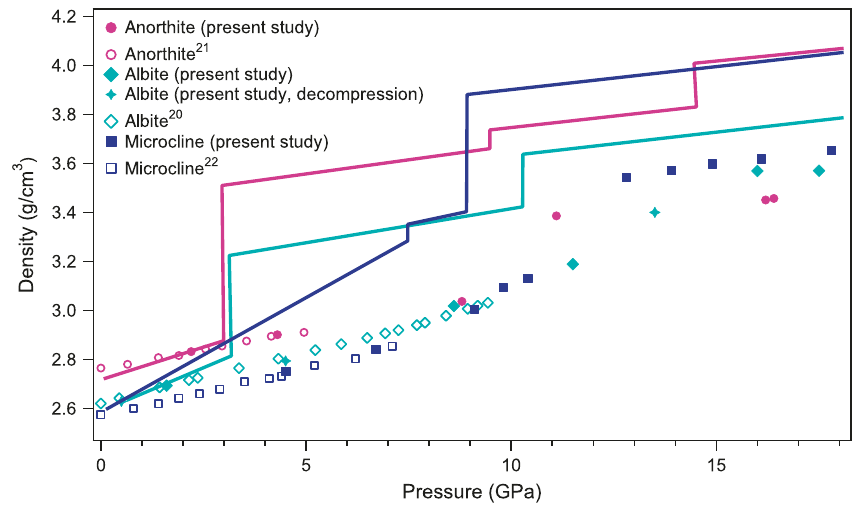
Fig. 3 Density-pressure evolution of feldspar compositions. Densities of metastable feldspars obtained in room-temperature, high-pressure single-crystal X-ray diffraction experiments are given as fi lled (present study) and open markers 20 – 22 . Above ~11 GPa, densi fi cation of the framework is realised through an increase in Al or/and Si coordination number to fi ve- and/or six-fold. Solid lines represent the evolution of feldspar compositions according to their decomposition reactions along P – T conditions of the normal mantle geotherm 34